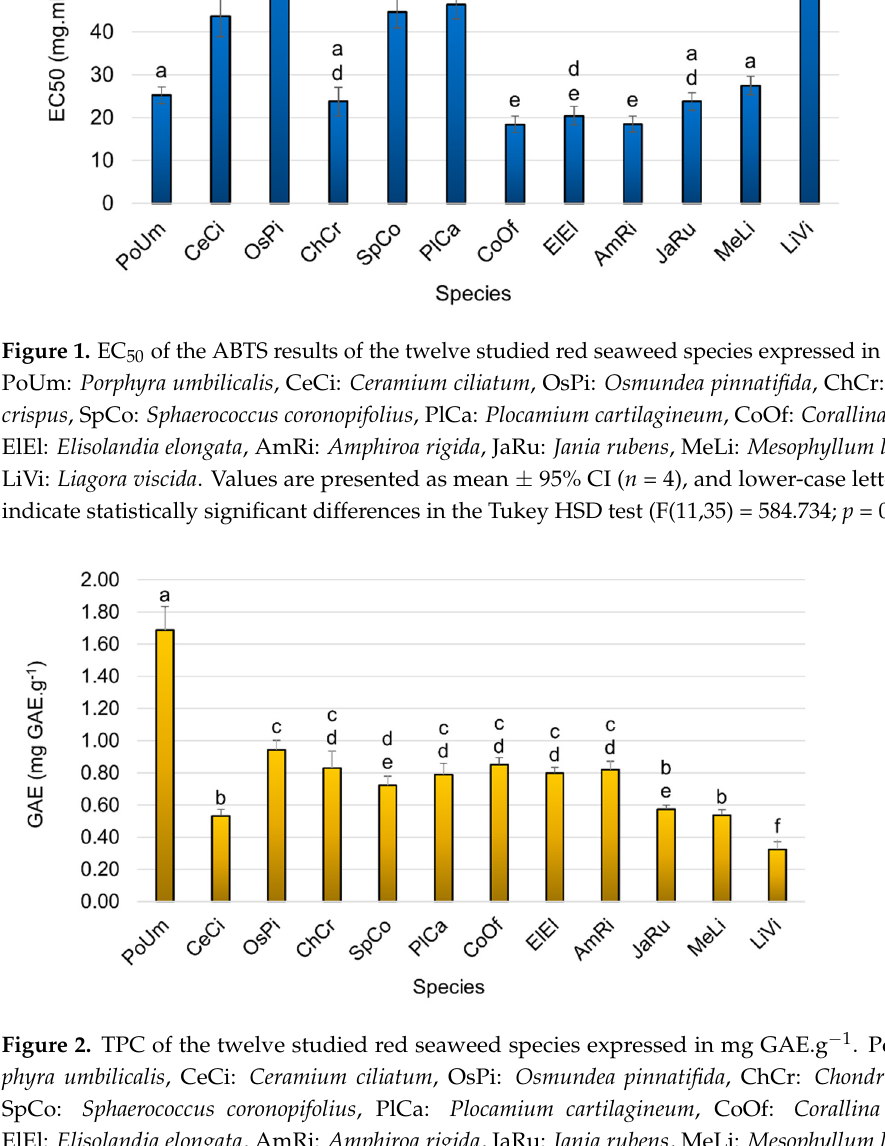
Table 2. Minimum Inhibitory Concentration (MIC) and respective extract concentrations for twelve red seaweed species, assessed against Bacillus subtilis and Saccharomyces cerevisiae . PoUm: Porphyra umbilicalis , CeCi: Ceramium ciliatum , OsPi: Osmundea pinnatifida , ChCr: Chondrus crispus , SpCo: Sphaerococcus coronopifolius , PlCa: Plocamium cartilagineum , CoOf: Corallina officinalis , ElEl: Elisolandia